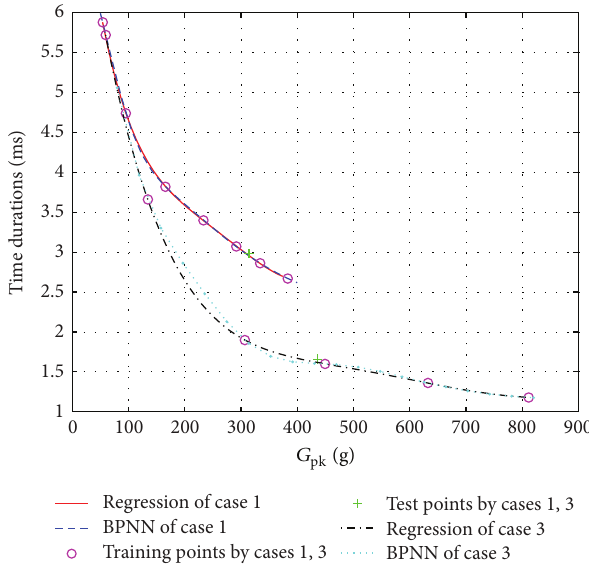
Figure 11: Fitting curves of 𝐷 versus 𝐺 in cases 1 and 3.